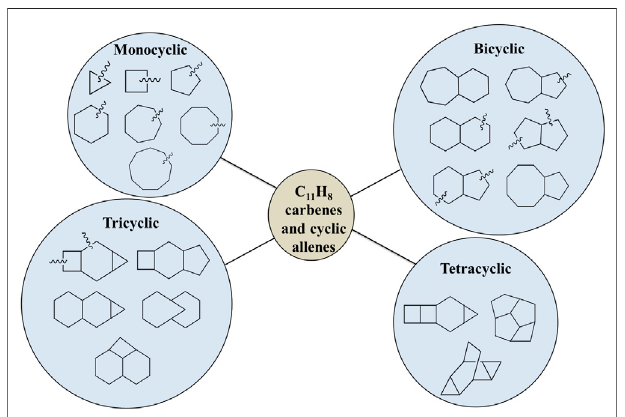
FIGURE 1 | Various types of skeletal representation of C 11 H 8 cyclic carbene/allene